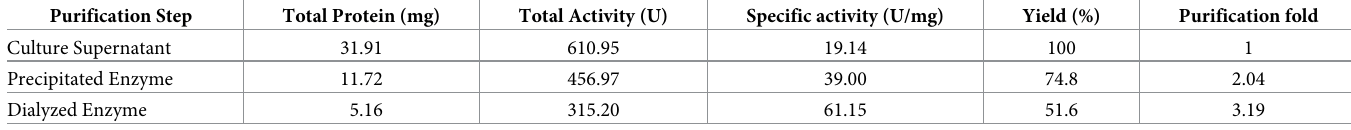
Table 3. Protein purification of protease enzyme from isolate